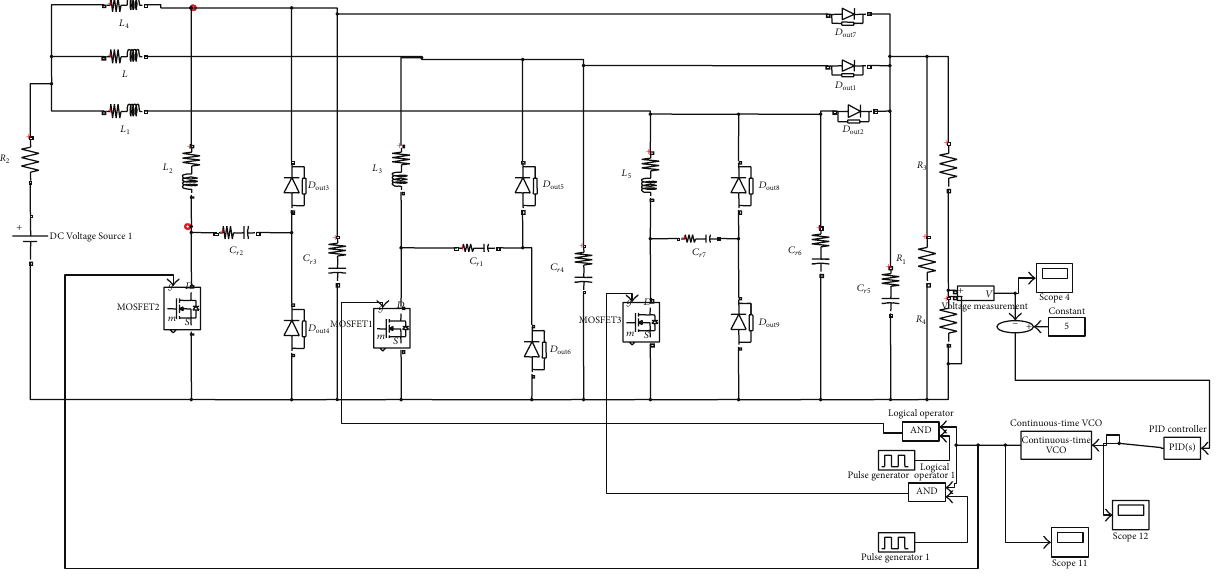
Figure 17: Simulink diagram of TSSSBC with